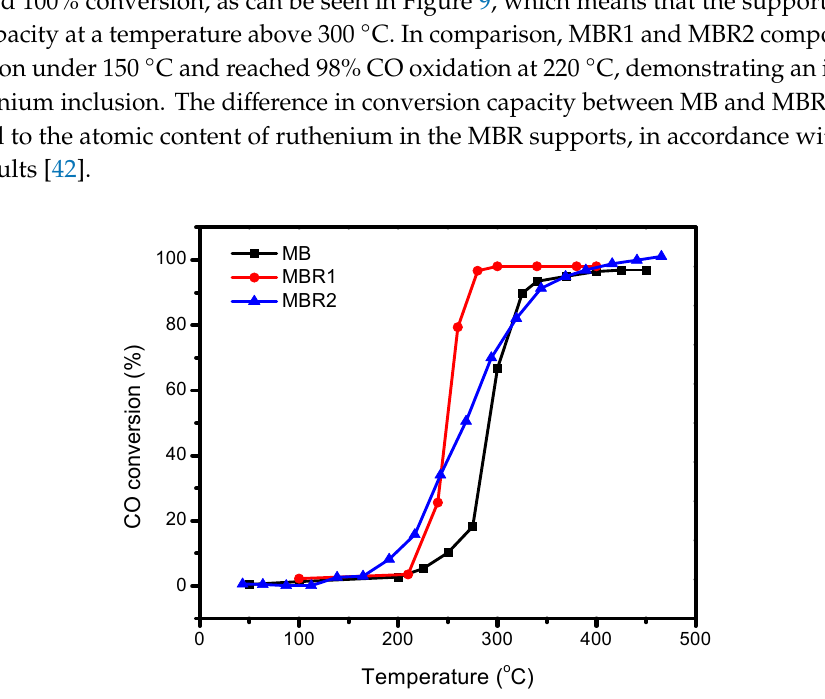
Figure 9. Comparative graph of CO conversion percentage for MB, MBR1, and MBR2 catalysts.